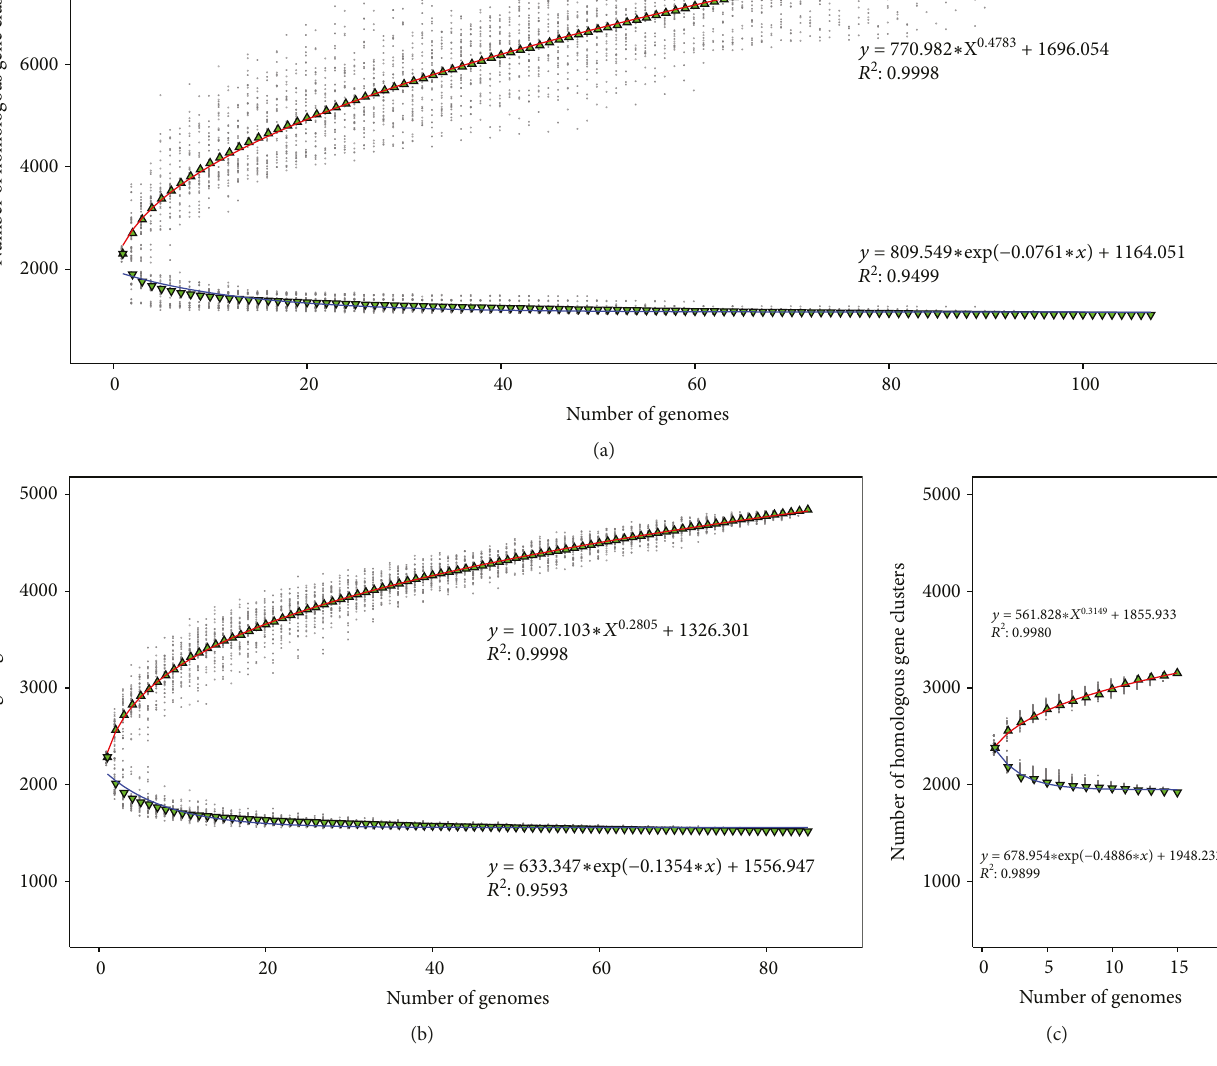
Figure 3: Core and pangenome size evolution. Blue and red curves represent core and pangenome fi tting curves for each group, respectively. (a) Core and pangenome of 107 Neisseria strain genomes using medians and a power law fi t. (b) Core and pangenome of 85 N. meningitidis genomes using medians and a power law fi t. (c) Core and pangenome of 15 N. gonorrhoeae genomes using medians and a power law fi